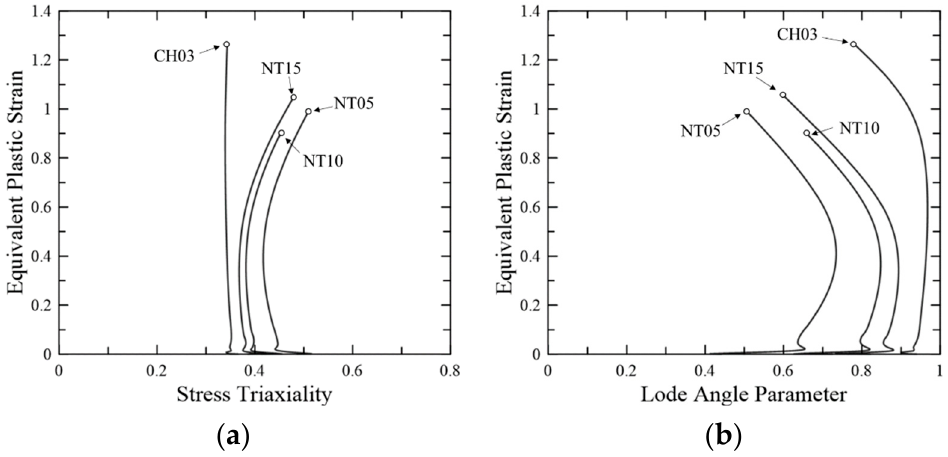
Figure 9. Equivalent plastic strain in accordance with ( a ) stress triaxiality and ( b ) Lode angle pa- rameter. Black line white dot indicates equivalent plastic strain at damage initiation. As plastic strain accumulates, the stress triaxiality and Lode angle parameters were continuously changed.